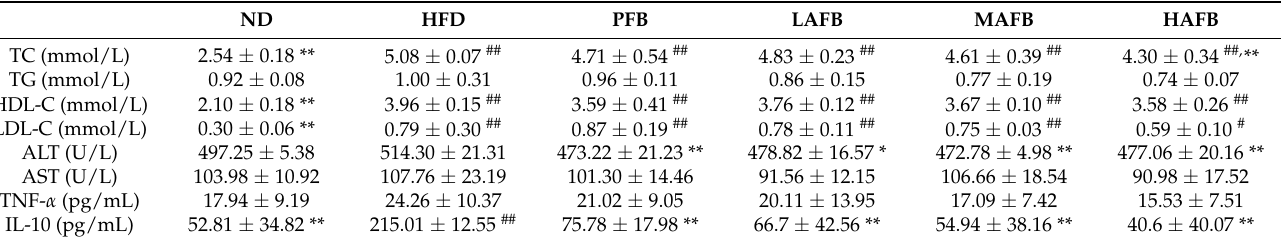
Table 1. Effect of AFB administration on serum parameters.